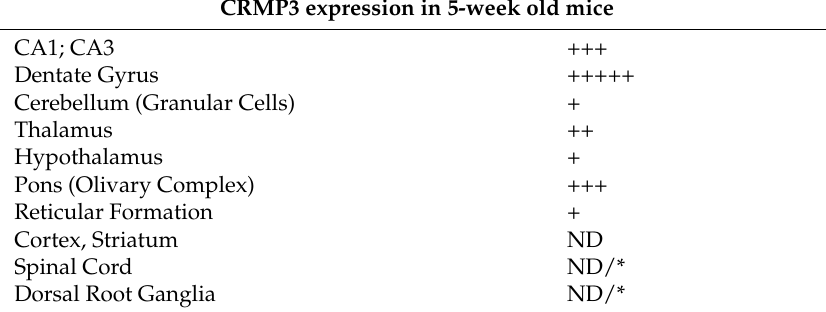
Table A1. Regional distribution of CRMP3 in the nervous system of post-natal mice. LacZ activity, as index of CRMP3 expression, was strongest in DG (ND: not detectable, *: present in one week old animals).